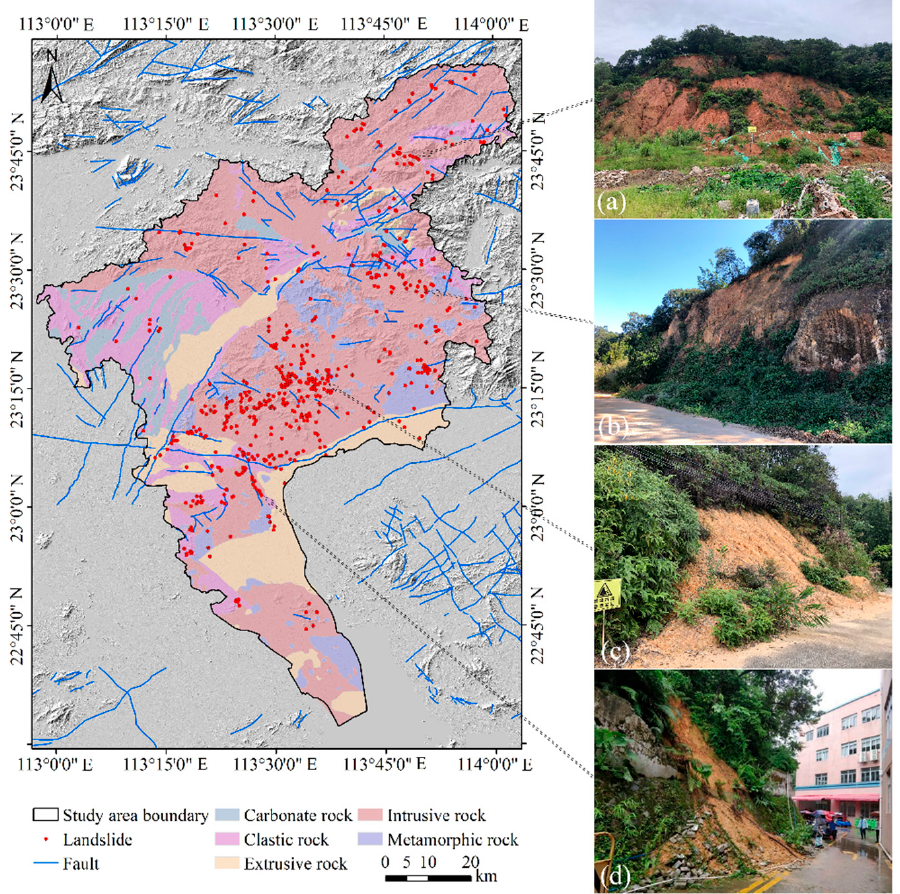
Figure 2. The geologic setting and the classifications of shallow landslide in Guangzhou: ( a ) and ( b ) Rotational sliding failure; ( c ) Planar sliding failure; ( d ) Toppling failure.